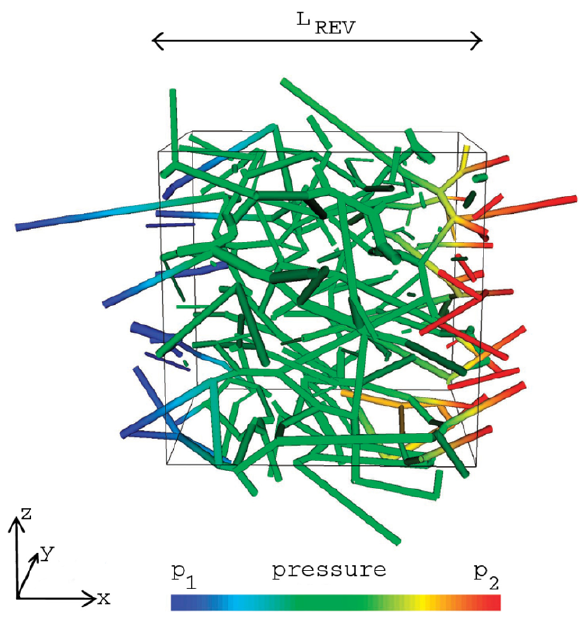
Figure 5. Computation of the effective permeability of a REV. Fixed pressures p 1 and p 2 set at all nodes crossing the left and right face normal to x respectively (no-flow boundary condition at all nodes crossing the other four faces). Effective permeability computed from pressure gradient and integral mass flow F REV through the REV’s capillary network (image modified from [9]).